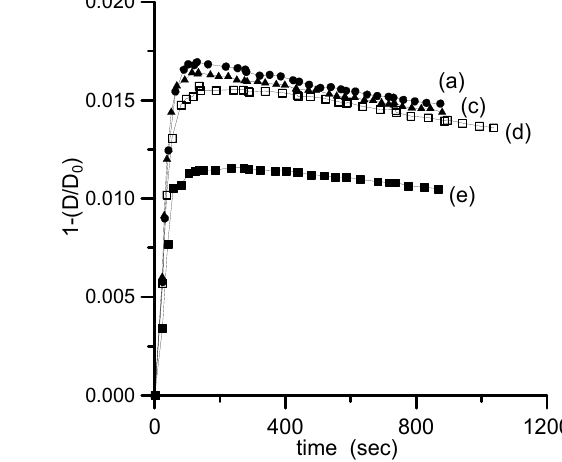
) for composite 0